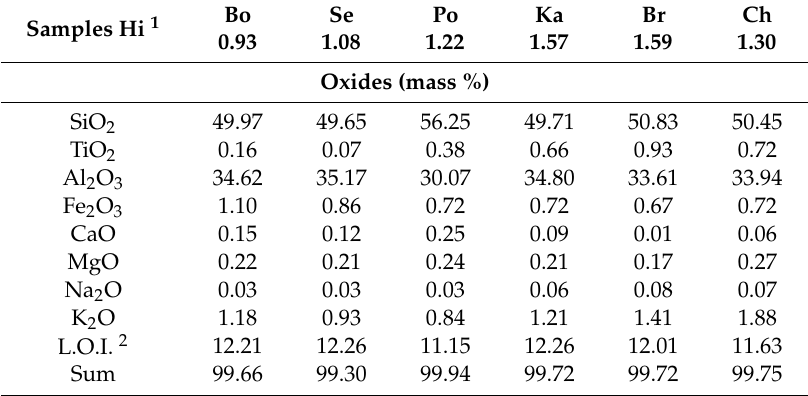
Table 1. ED-XRF analysis of kaolin